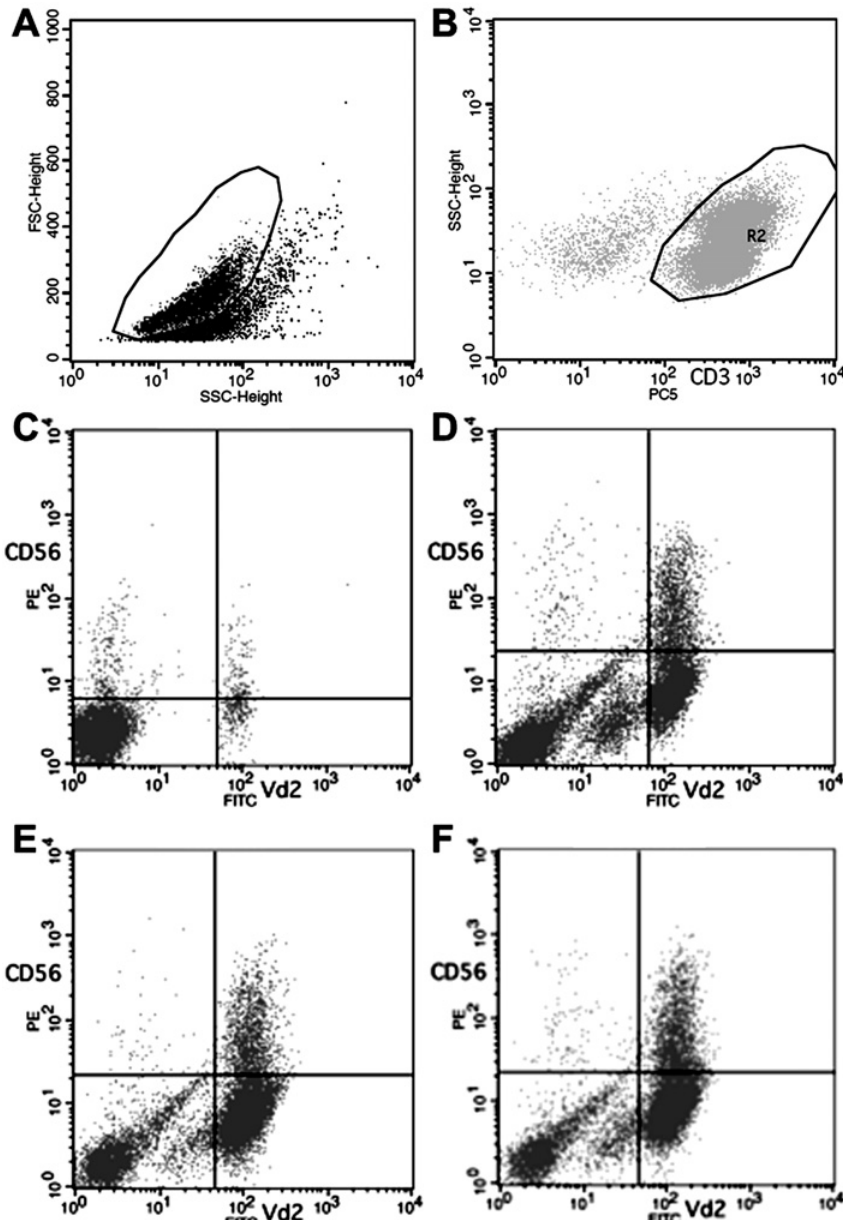
Figure 1. Representative flow cytometry results for control 1-1. Mononucleocytes were selected via forward scatter (FSC) and side scatter (SSC) ( A ). Then, T-cell antigen receptor-expressing cells were selected using CD3 antibody ( B ). Pre-culture γδ T cells were measured using V δ 2 (Vd2) and CD56 at day 0 ( C ). V δ 2-expressing cells increased during 12-day culturing with 0 μ g β -TCP ( D ). Further ex- pansion of V δ 2-expressing cells via 30- ( E ) and 100- μ g ( F ) β -TCP stimulation is shown. All Vd2 posi- tive cells were counted as γδ T cells regardless of whether CD56 was positive or